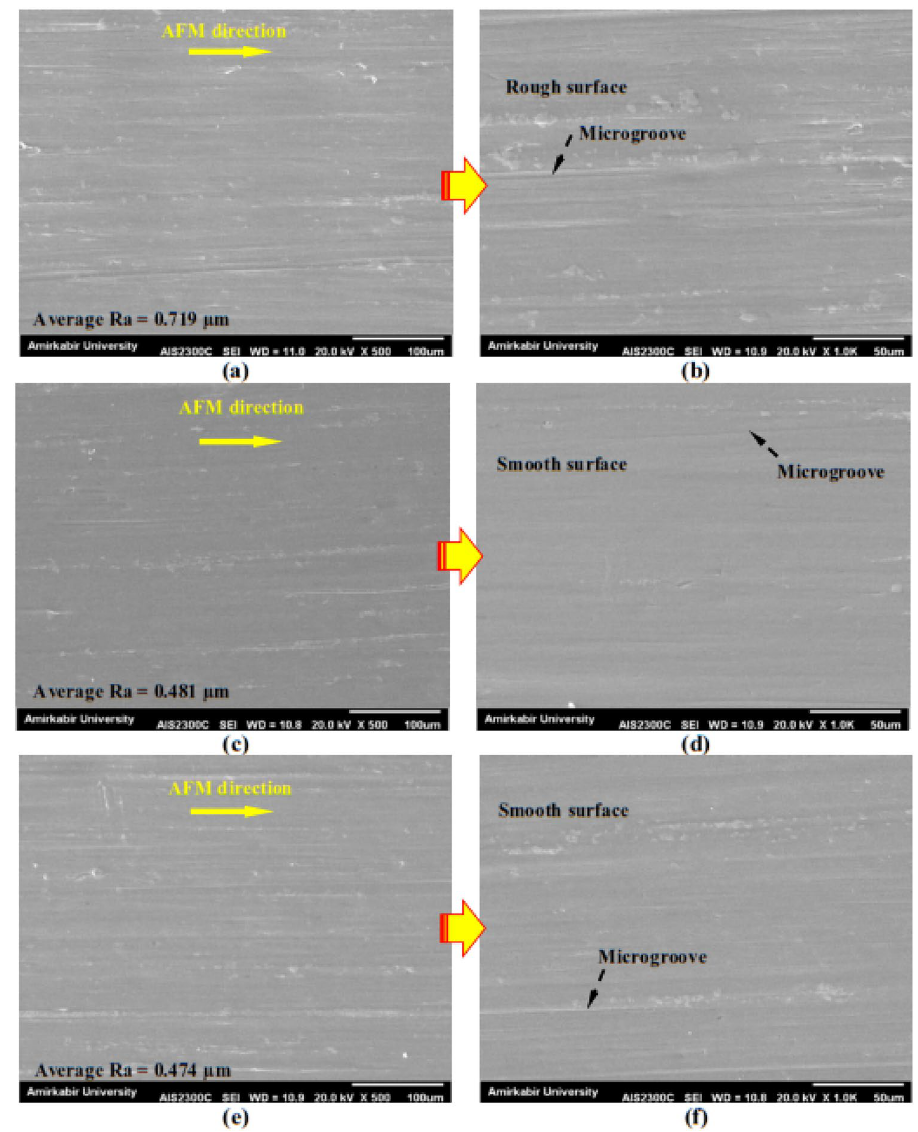
Fig. 6 The morphology of machined surface of samples using AFM process at the dif- ferent number of AFM cycles: a , b 60, c , d 120, and e , f